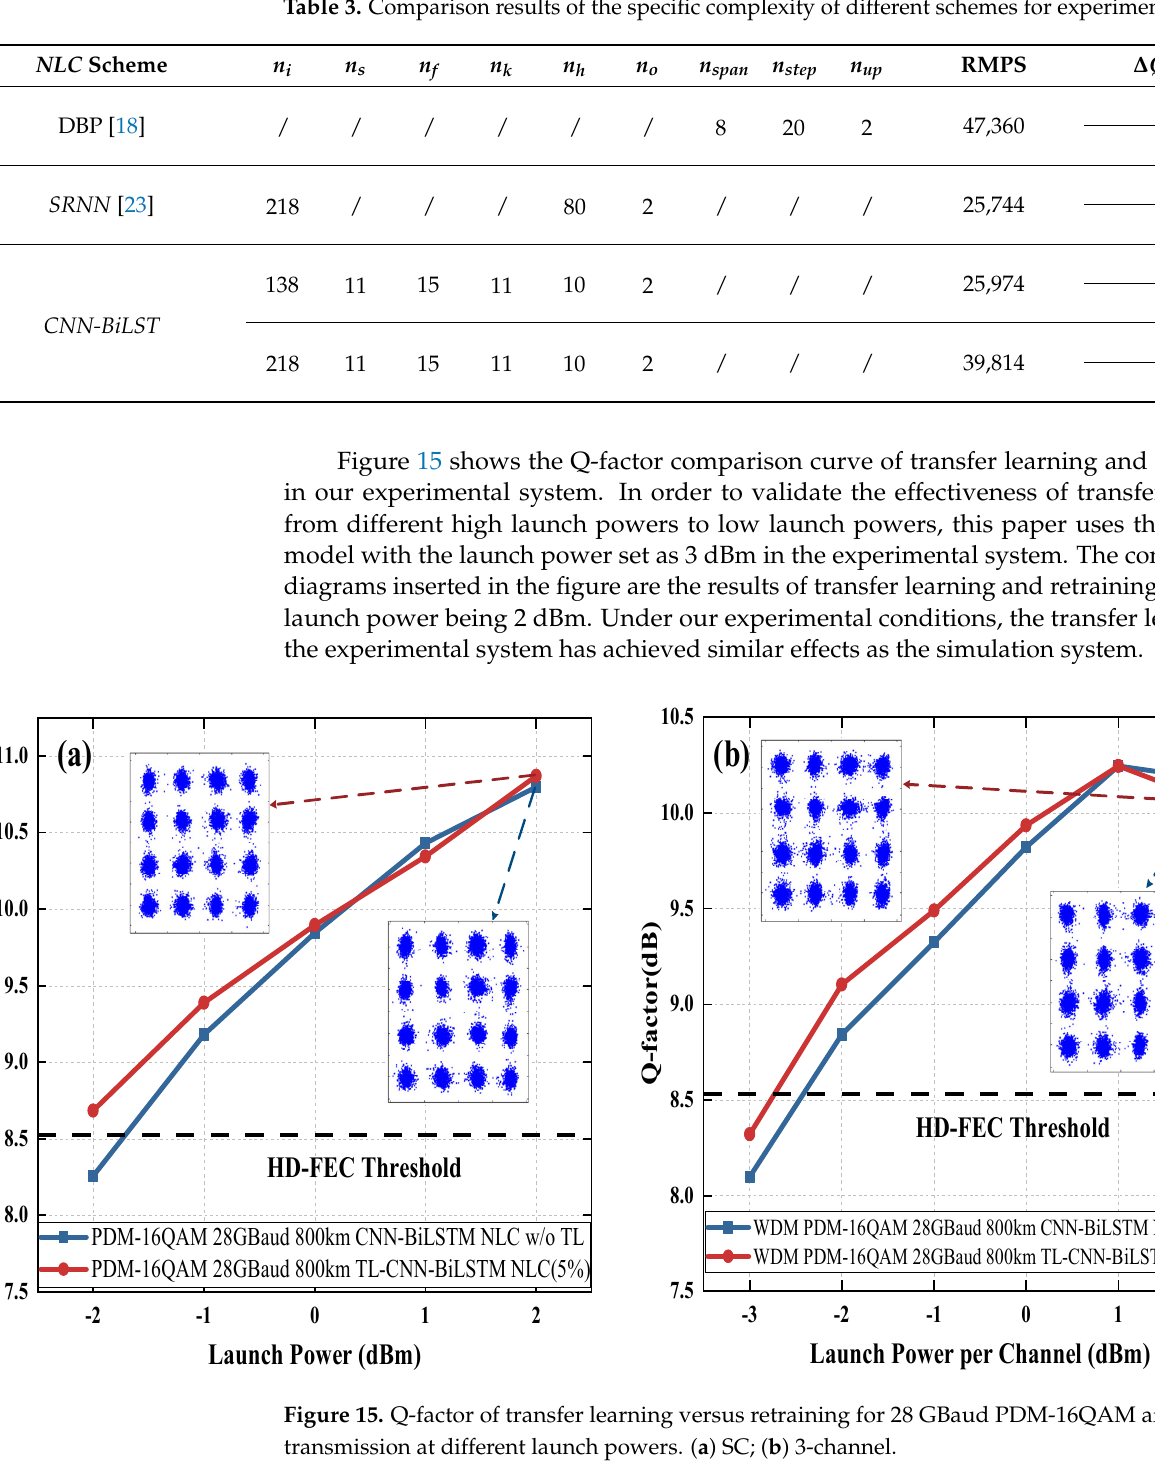
16 of 19 Figure 14. Q-factor of different NLC schemes versus launch power for 28 GBaud PDM-16QAM transmission system over 800 km. ( a ) SC; ( b ) 3-channel. Table 3 shows the key parameters and corresponding RMPS complexity of different